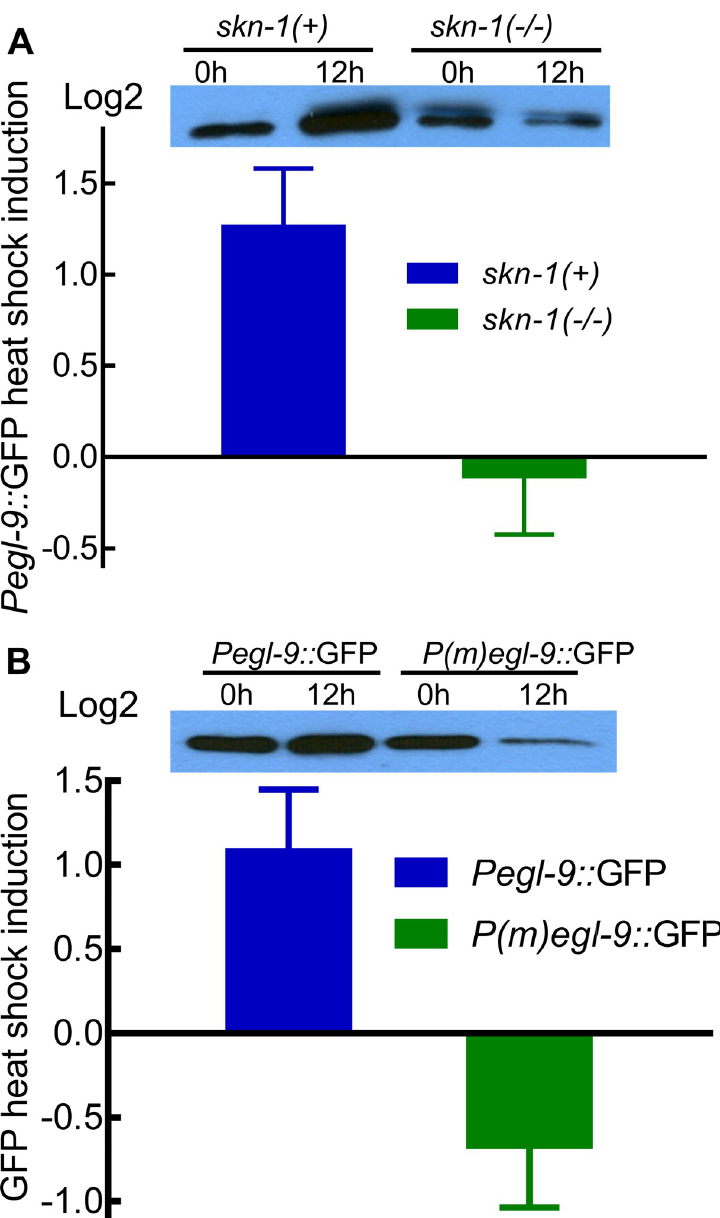
Fig 5. SKN-1 acts through the putative SKN-1 binding site in the egl-9 promoter to activate egl-9 expression. (A) Heat shock induced Pegl-9 :: GFP in animals carrying the wild-type s kn-1 allele, but did not induce the reporter in animals carrying the skn-1(zu67) loss-of-function mutation. The vertical axis shows the log2 fold changes of GFP caused by heat shock for each strain with standard errors, as determined by four biological replicates. A representative western blot is shown. For each sample, 20 L4- stage worms were boiled and lysates corresponding to 10 worms were loaded to each lane. (B) Heat shock increased the expression of Pegl-9 :: GFP , but did not increase the expression of the reporter in which the putative SKN-1 binding site was mutated ( P(m)egl-9 :: GFP ). The vertical axis shows the log2 fold changes of GFP caused by heat shock for each strain with standard errors, as determined by five biological replicates. A representative western blot is shown. For each sample, 20 L4- stage worms were boiled and lysates corresponding to 10 worms were loaded to each lane.